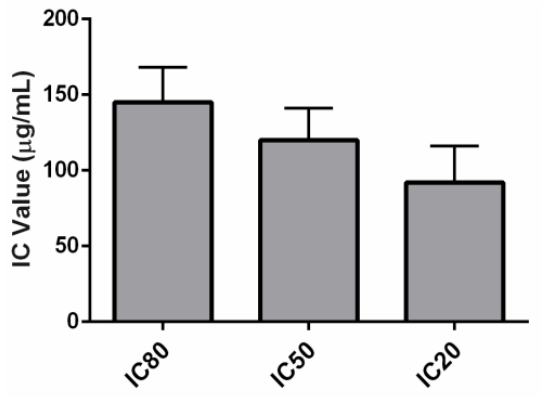
Figure 5. Cytotoxicity evaluation of the AgNPs biologically synthesised by the fungus C. thermophilum using the NRU assay with the skin fibroblasts from the murine embryo Balb/c 3T3 NIH cell line: IC values. Table 1. Cytotoxicity evaluation of the AgNPs biologically synthesised by the fungus C. thermophilum using the NRU assay with the skin fibroblasts from the murine embryo Balb/c 3T3 NIH cell line: IC values, the predicted LD 50 (which, given all at once, could cause the death of 50% of a group of test animals) and the GHS for the AgNPs’ cytotoxic effects.